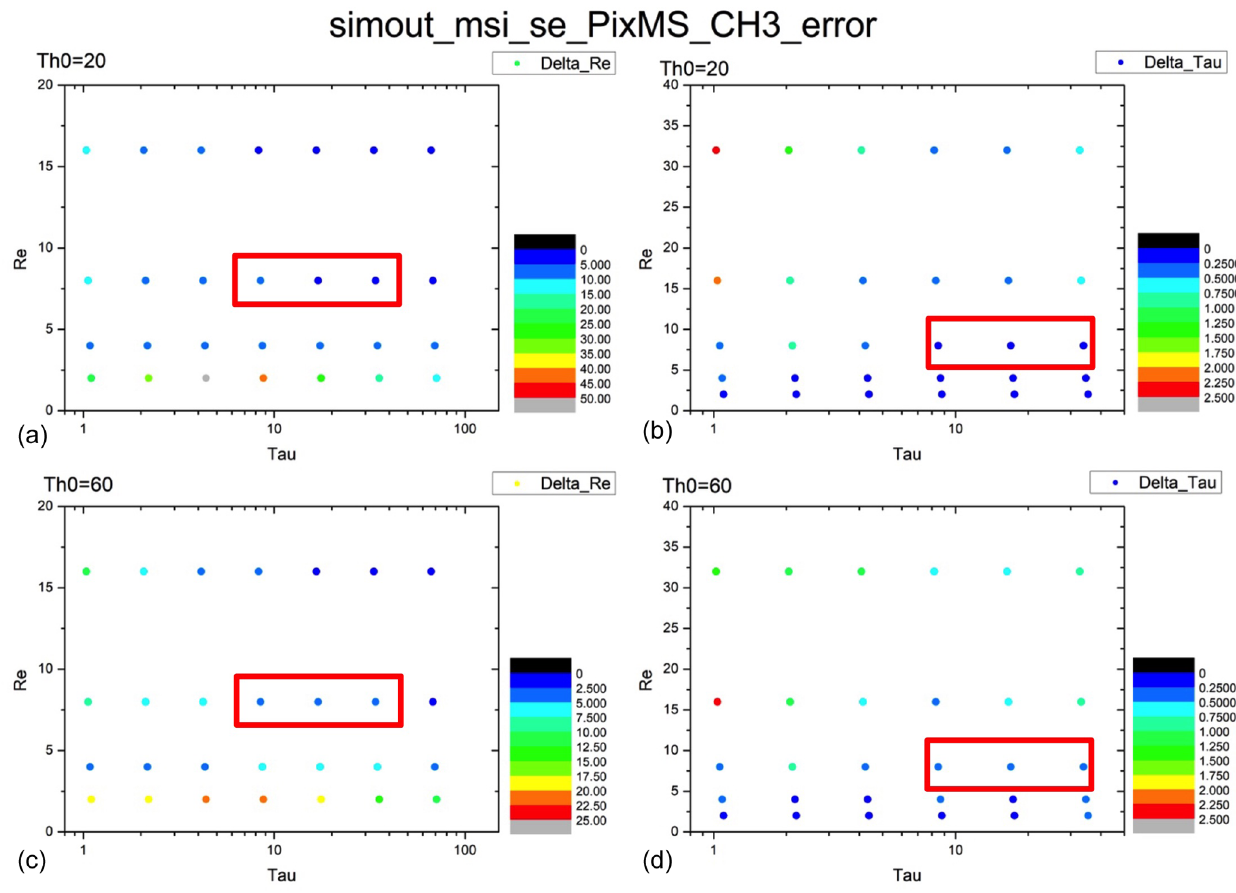
Figure 9. Error distributions of COT and CDR from the Nakajima–King diagram for shallow warm clouds at pix_BND3_min. (a) Distribution of (cid:49)r e for a solar zenith angle of 20 ◦ . (b) Distribution of (cid:49)τ for a solar zenith angle of 20 ◦ . (c) Distribution of (cid:49)r e for a solar zenith angle of 60 ◦ . (d) Distribution of (cid:49)τ for a solar zenith angle of 60 ◦ . The red frames show the presence of typical shallow warm cloud. COT = 8 or 32, CDR =